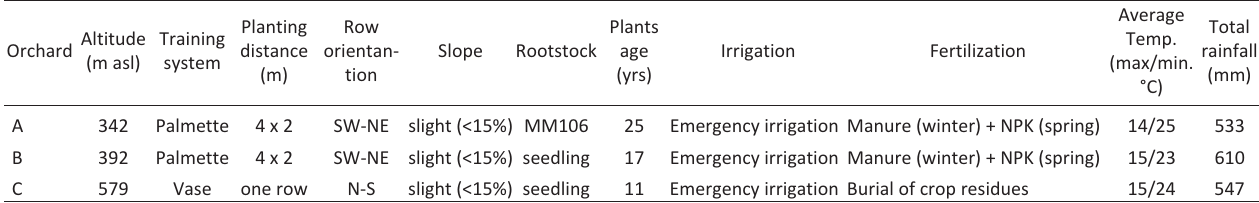
(right).Table Table 2 ­ Maturity indices of ‘Pomella Genovese’ apples at har­ vest Different letters indicate significant differences (LSD Fig. 1 ­ Fruit of ‘Pomella Genovese’ watercore­free (left) or affected by different levels of watercore